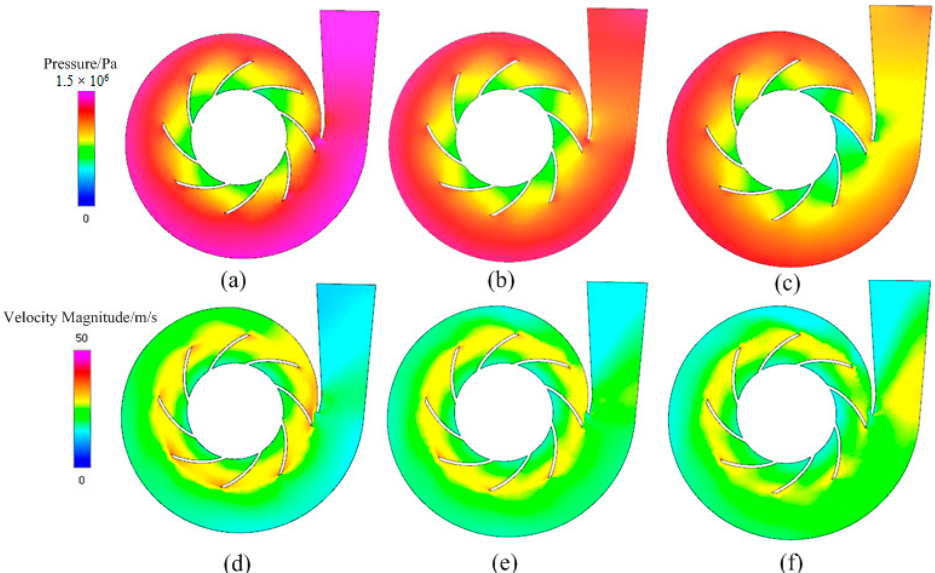
Figure 7. Static pressure and relative velocity distributions at the axial section of the combination impeller: ( a ) static pressure, 0.8 Q d ; ( b ) static pressure, 1.0 Q d ; ( c ) static pressure, 1.2 Q d ; ( d ) relative velocity, 0.8 Q d ; ( e ) relative velocity, 1.0 Q d ; ( f ) relative velocity, 1.2 Q d .